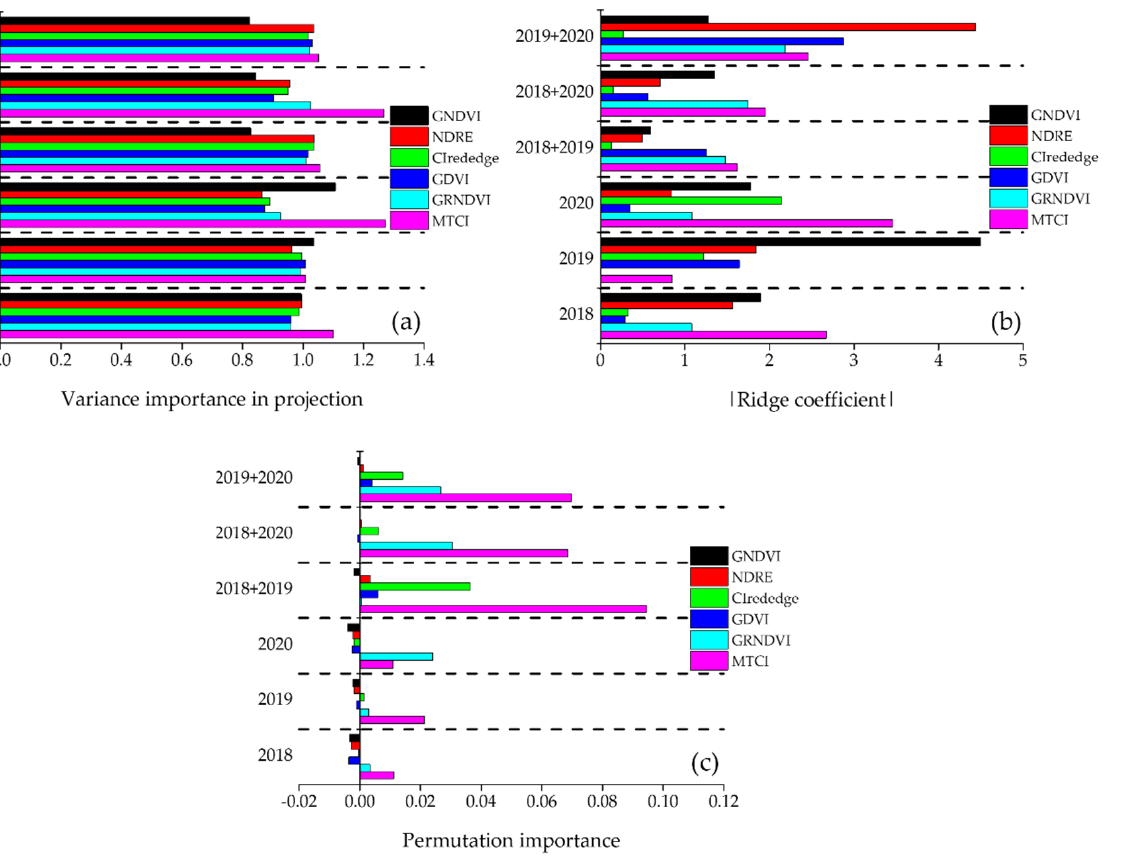
Figure 8. Importance of each vegetation index for the ( a ) PLSR-, ( b ) RR-, and ( c ) ANN-based prediction of the rice-protein content.